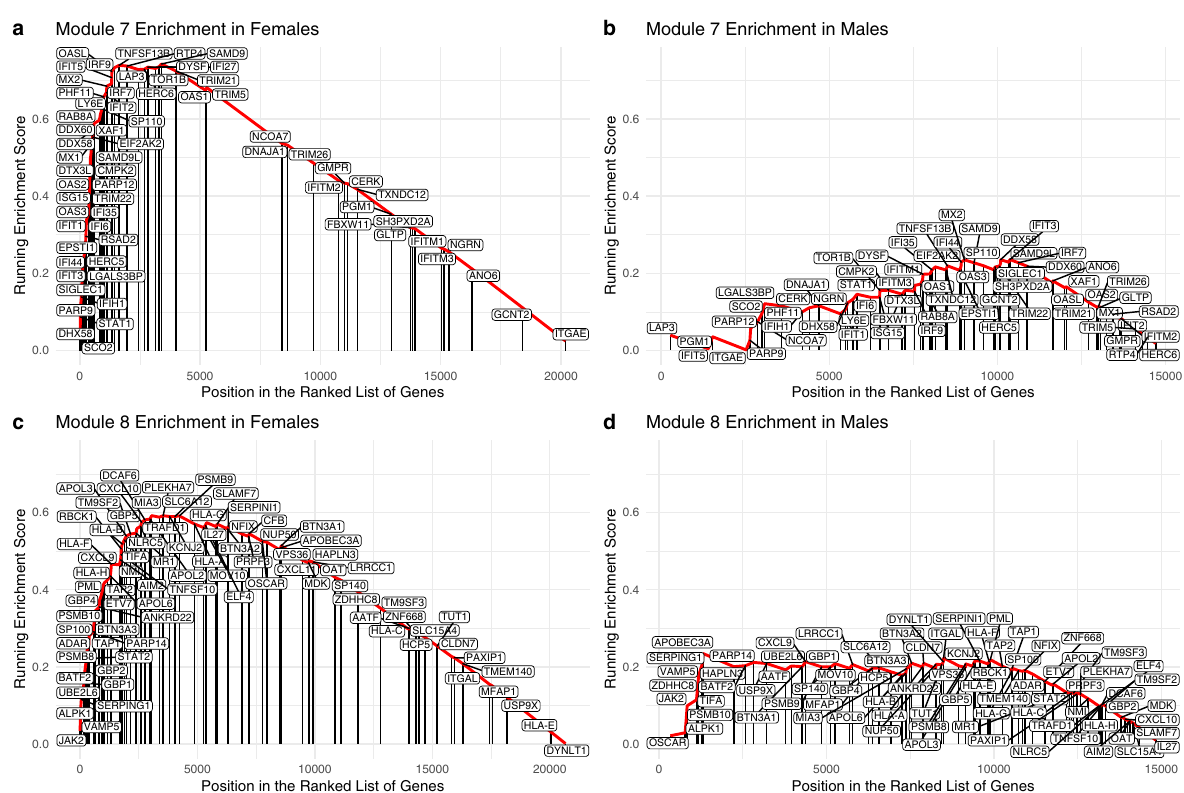
Fig. 7 Classical M1 pro-in fl ammatory gene modules enriched for differences between PD and HC in female cohort but not male cohort. Gene Set Enrichment Analysis (GSEA) was performed separately for each sex. Enrichment results for Module 7 in females ( a ), enrichment results for Module 7 in males ( b ), enrichment for Module 8 in females ( c ), and enrichment results for Module 8 in males ( d ) are shown. Two gene modules (of the 49 tested) were enriched in females (Modules 7 and 8, FDR q -value < 0.001). Both are classical “ M1 ” pro-in fl ammatory gene programs, and strongly associated with response to IFN γ . No gene modules achieved statistical signi fi cance in males. Genes in each individual module are labeled at the position in which they appear in the ranked gene list (ranked by the absolute value of the Wald test statistic value between PD and HC) for females and